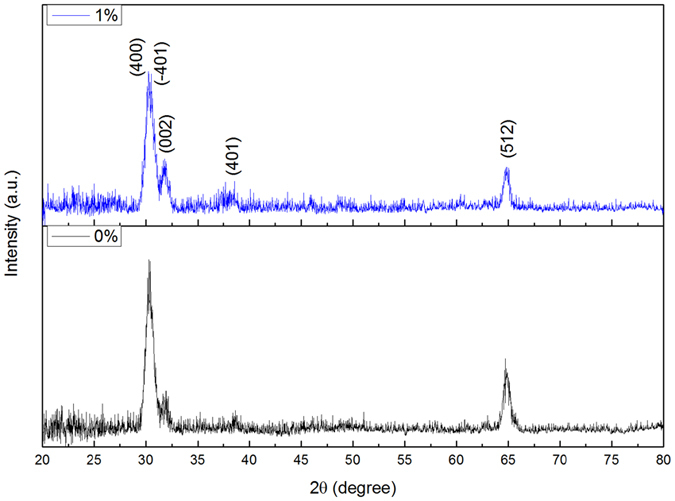
XRD patterns of the β-Ga2O3 films deposited under different O2 volume percentage.